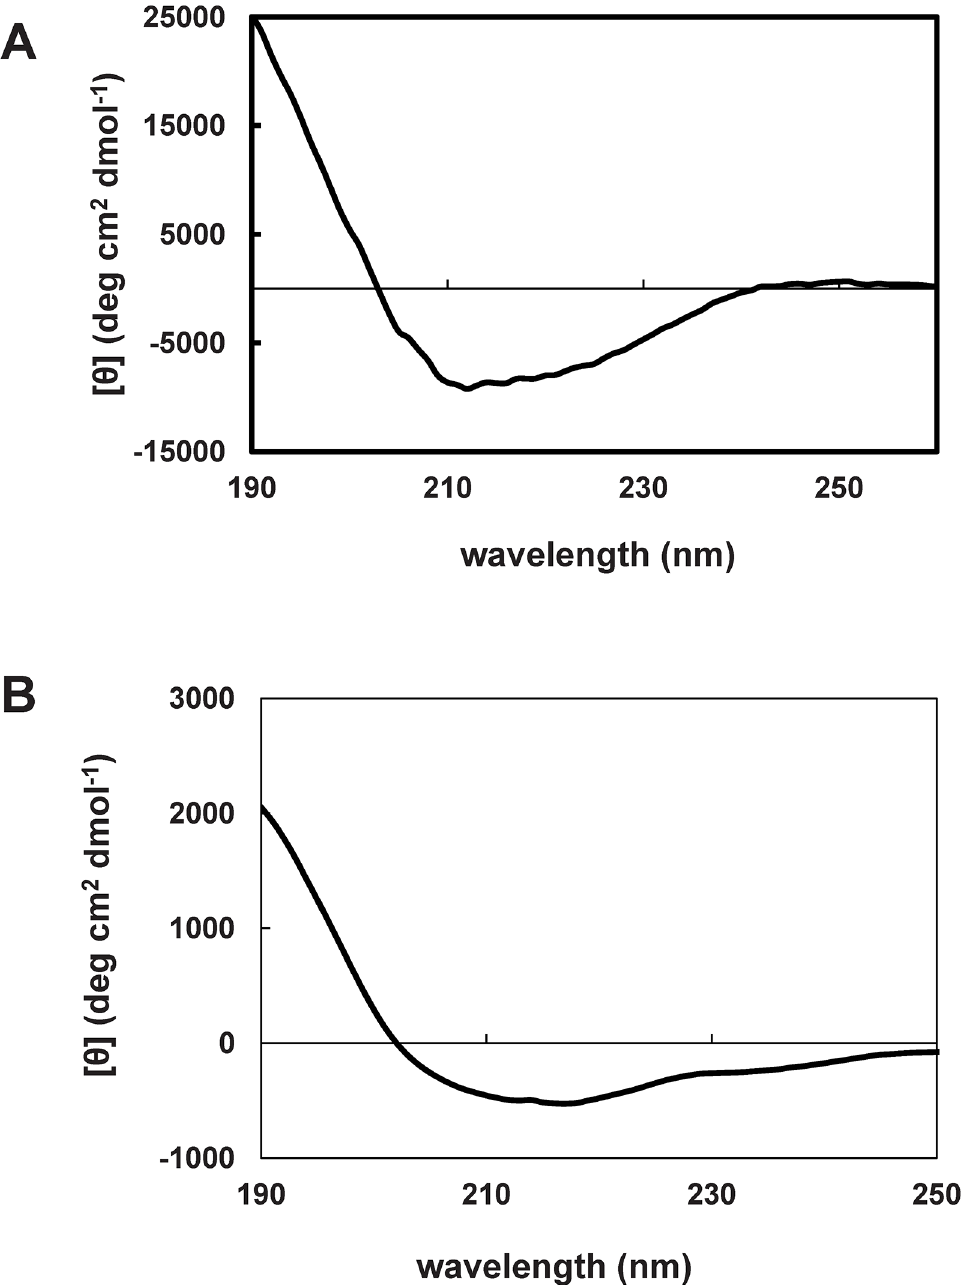
Fig 3. Circular dichroism spectra for Sf β gly-N and Sf β gly-C. Purified samples of 0.22 mg/mL Sf β gly-N (A) and 0.25 mg/mL Sf β gly-C (B) prepared in 10 mM potassium phosphate buffer, pH 6.9, were used for spectrum determination at 25°C (n = 8 reads).